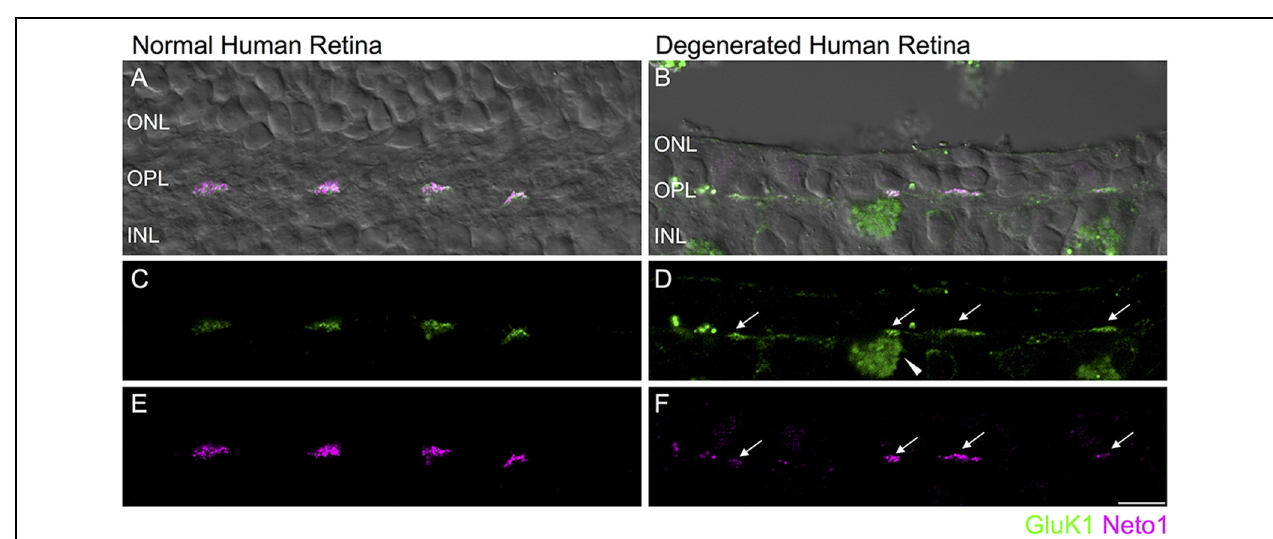
FIGURE 6 | Retention of kainate receptors after photoreceptor degeneration in human retina. (A,B) Immunolocalization of GluK1 (green) and Neto1 (magenta) in normal human peripheral retina (A) and in degenerated human retina (B) . The fluorescence image is superimposed on the transmitted light image (gray) to show retinal morphology. (C,D) Clusters of GluK1 staining in the normal and degenerated retina (arrows). An autofluorescent pigment epithelial cell is indicated by the arrowhead. (E,F) Same region as in (C,D) showing clusters of Neto1 staining. Scale bar = 10 μ m.